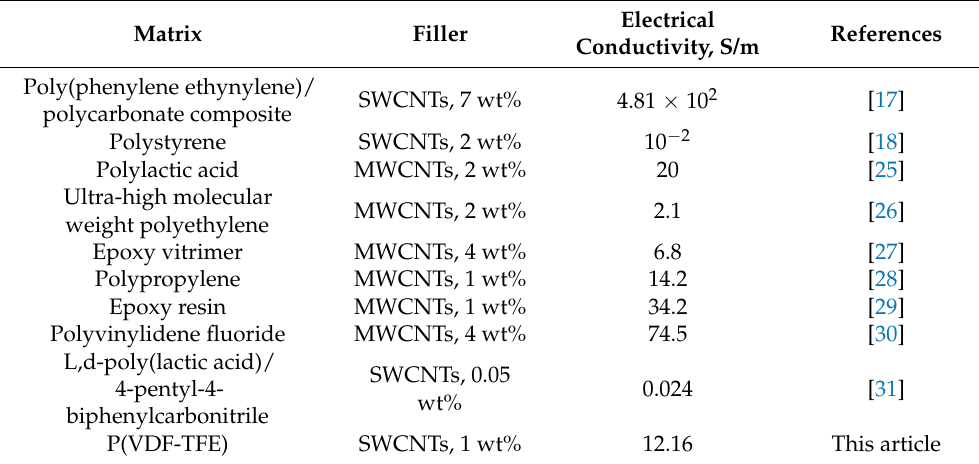
Table 2. Experimental values of the electrical conductivity of polymer composites based on CNT described in the